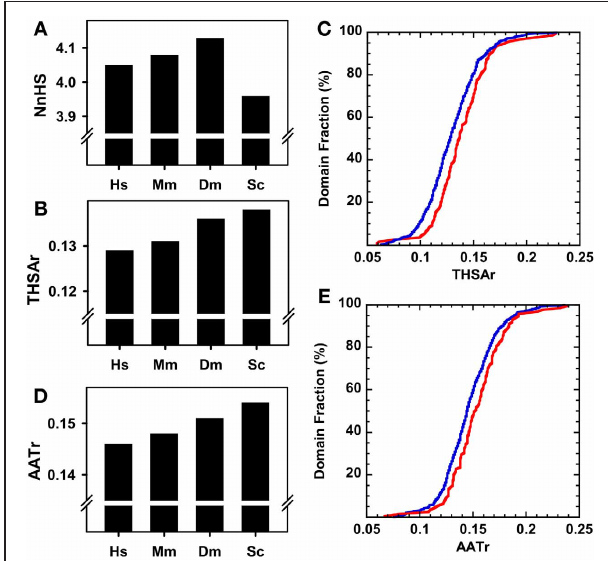
FIGURE 3 | Aggregation properties of complete kinase domain datasets of different organisms. (A) Normalized number of Hot-spots (NnHS). (B) Total Hot-spot area per residue (THSAr). (C) Distribution of the THSAr value along the whole dataset. (D) Area of the aggregation profile above the Hot-Spot Threshold per Residue (AATr). (E) Distribution of the AATr value over the complete kinase domain dataset. In (A) , (B) , and (D) : human ( Hs ), mouse ( Mm ), fruit fly ( Dm ), and budding yeast ( Sc ). In (C) and (E) : the blue line corresponds to the human dataset and the red line to the yeast kinome.